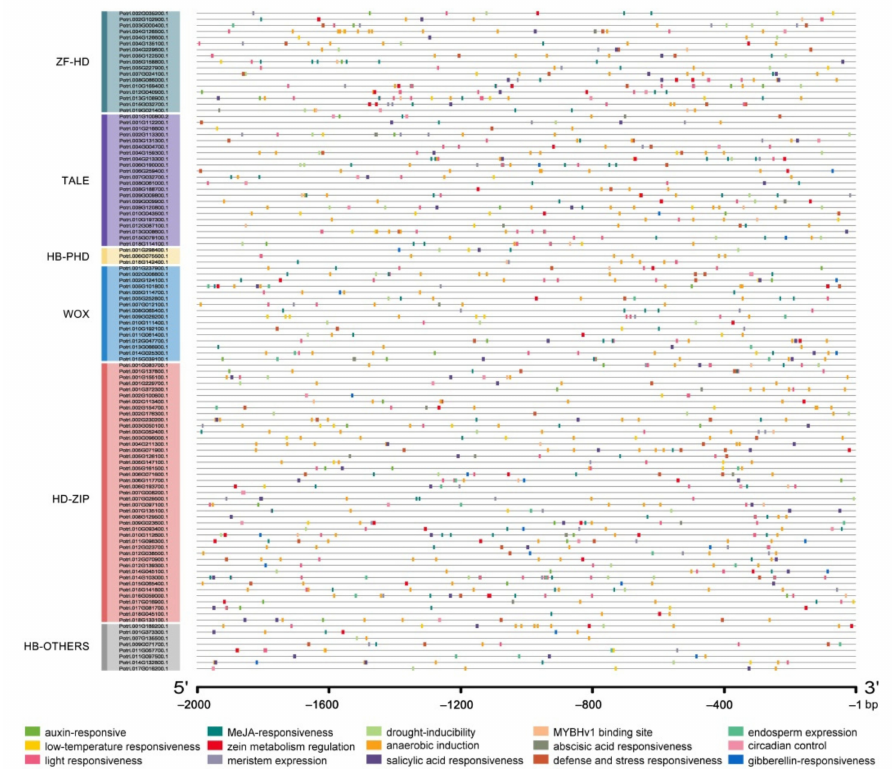
Figure 5. Distribution of major cis-acting elements in the promoters of the poplar PtrHB genes. Putative cis-acting elements, including auxin-responsive, MeJA-responsiveness, drought-inducibility, MYBHv1 binding site, endosperm expression, low-temperature responsiveness, zein metabolism regulation, anaerobic induction, abscisic acid responsiveness, circadian control, light responsiveness, meristem expression, salicylic acid responsiveness, defense and stress responsiveness and gibberellin responsiveness, are visualized by different color